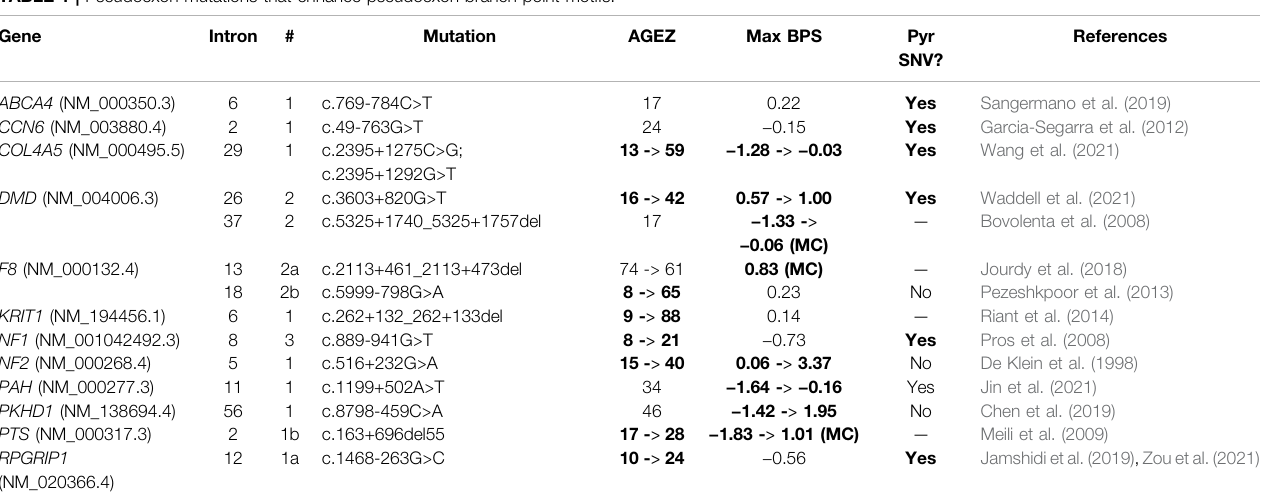
TABLE 1 | Pseudoexon mutations that enhance pseudoexon branch point motifs.